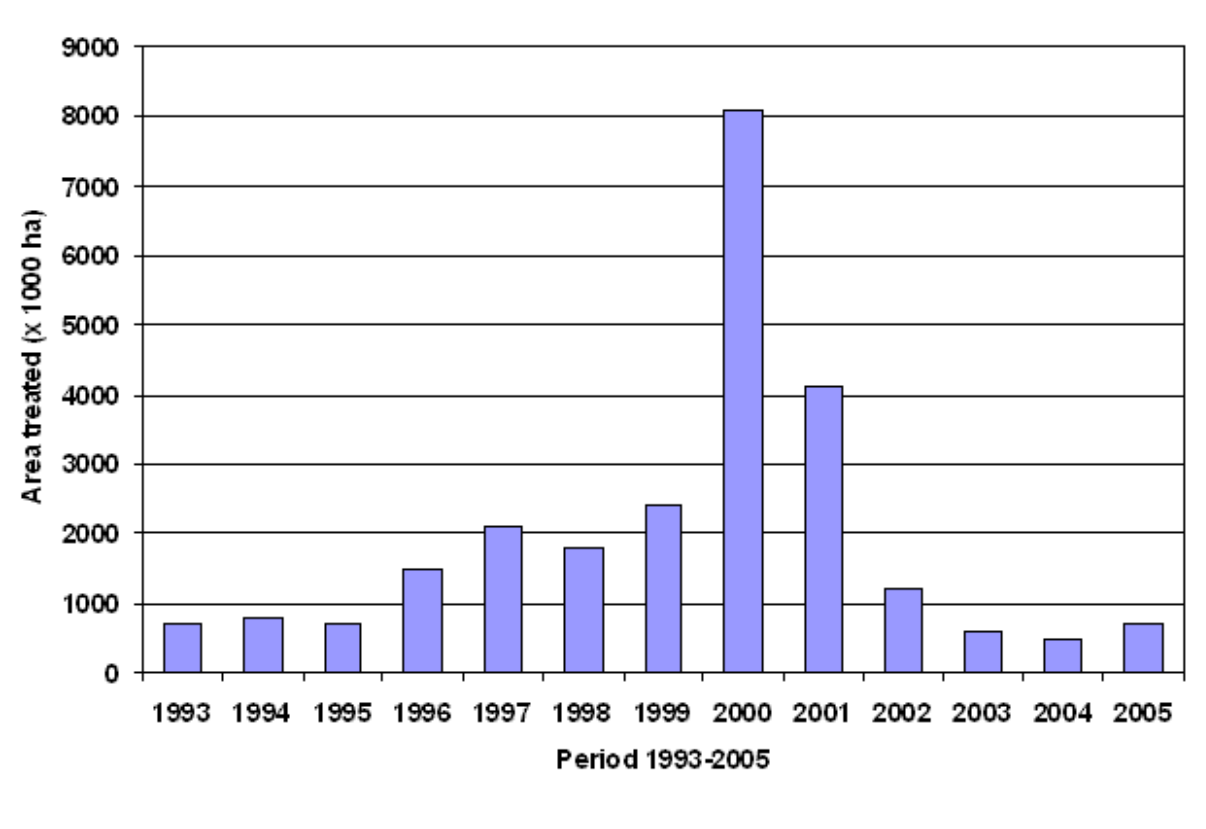
Fig. 3. Total area treated against all species of locusts in Kazakhstan from 1993 to 2005. Source: Ministry of Agriculture of